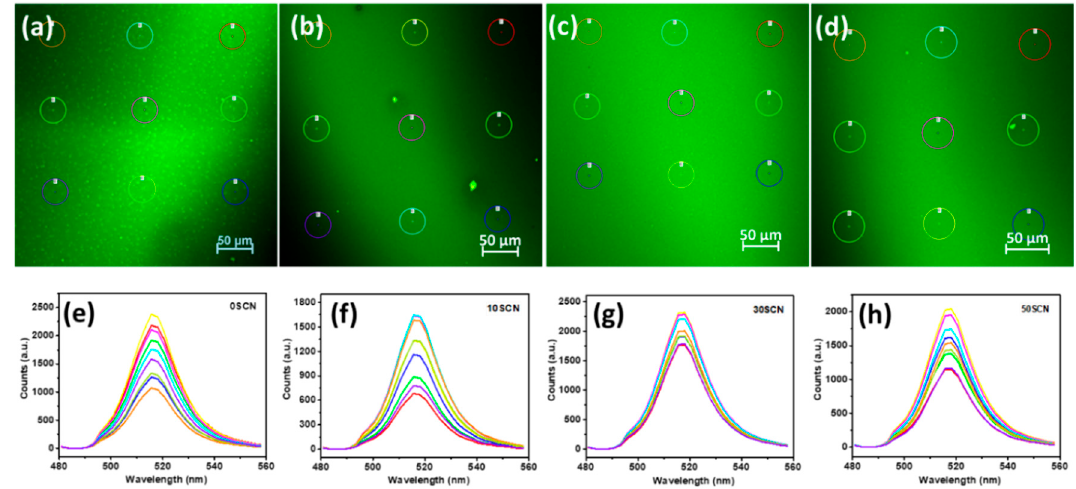
Figure 2. PL mapping images of NC films based on ( a ) 0SCN, ( b ) 10SCN, ( c ) 30SCN and ( d ) 50SCN NC solutions; ( e – h ) PL spectra of selected areas in each of the corresponding PL mapping images.